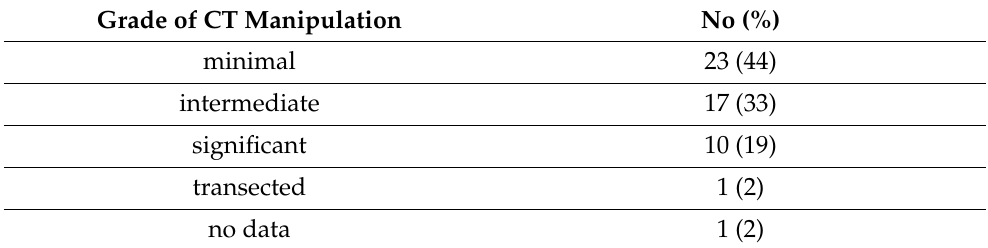
Table 9. The Grade of Chorda Tympani